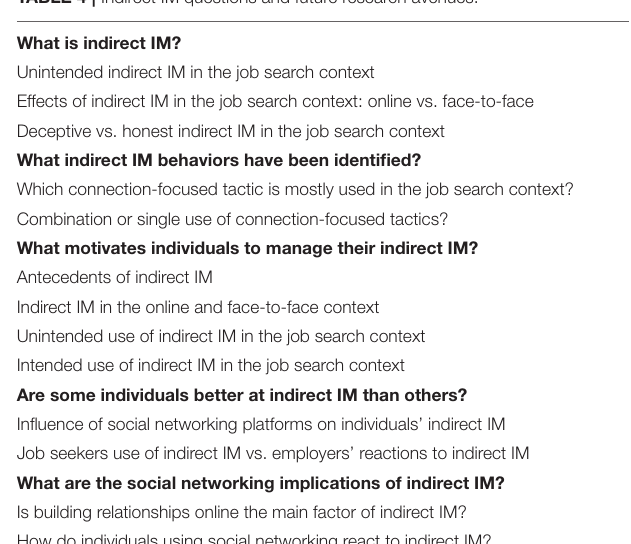
TABLE 4 | Indirect IM questions and future research